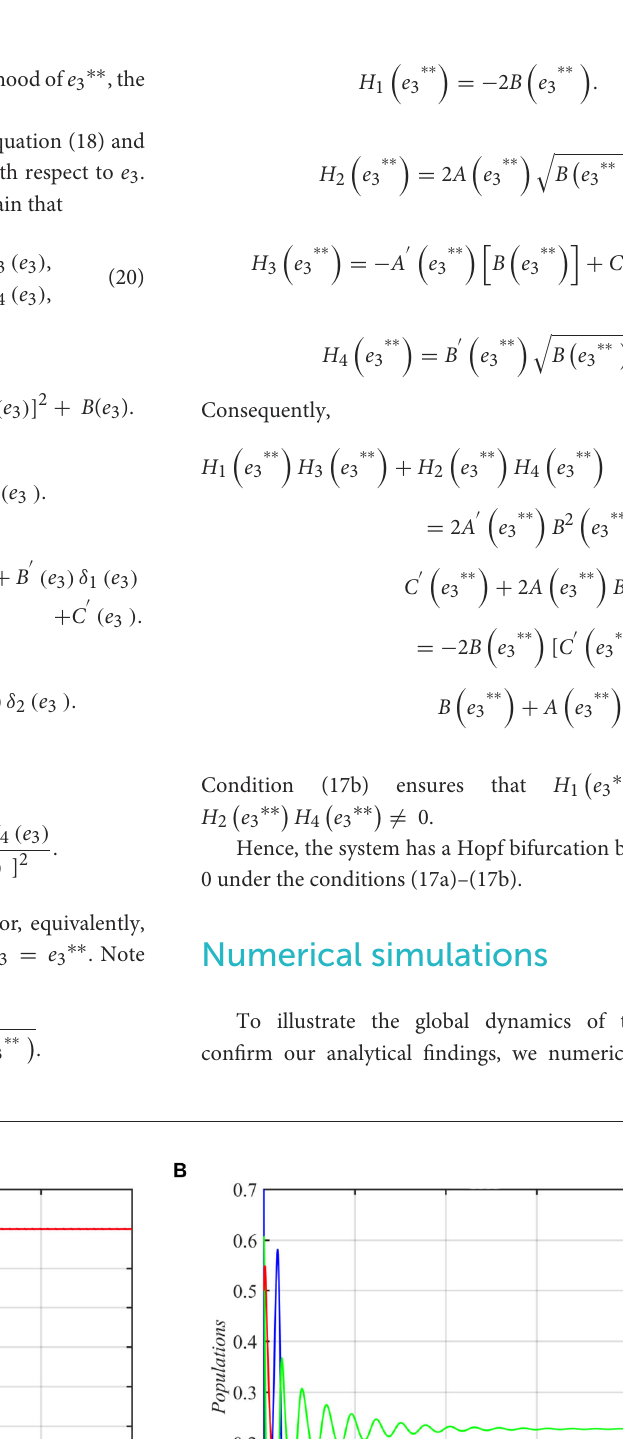
0.3, which approach E 3 = =